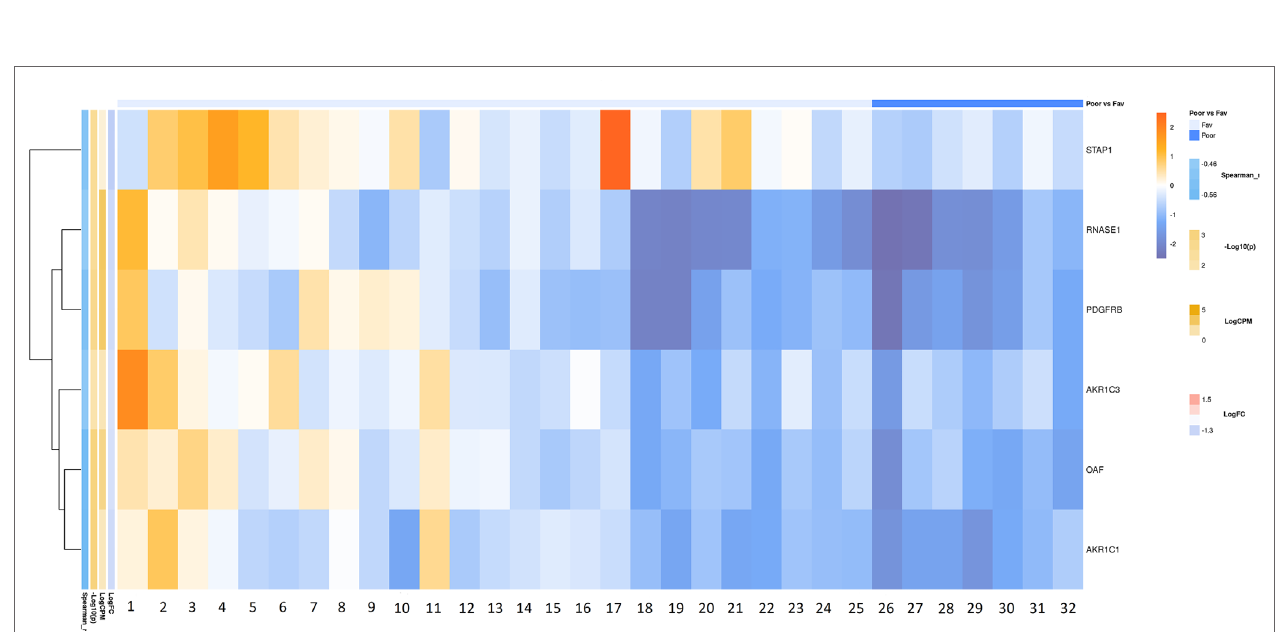
FIGURE 6 | Potential markers of unfavorable prognosis in lymph node-negative LAPC involved in the enriched KEGG pathways (TCGA data, TMPRSS2-ERG- positive samples). LogFC—trimmed binary logarithm of average expression-level fold change (between the groups of favorable and unfavorable prognosis); LogCPM—binary logarithm of